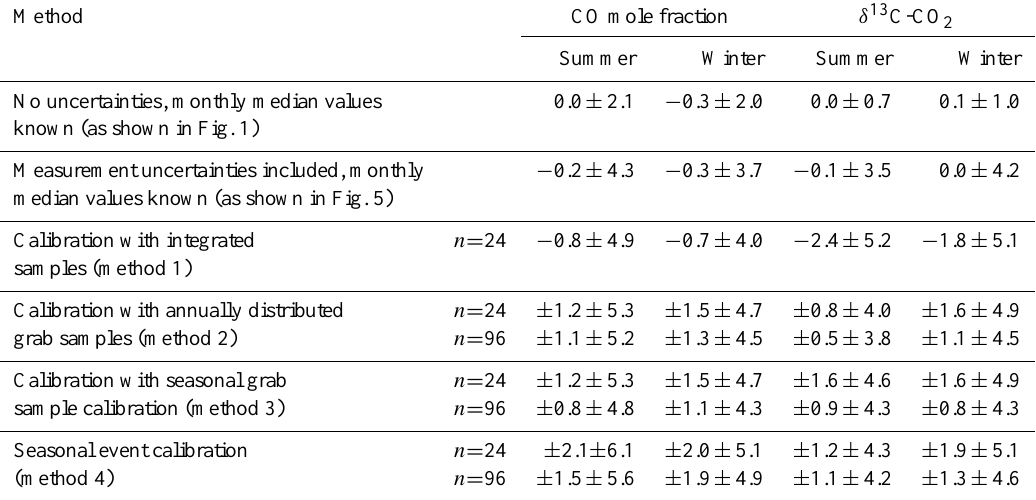
Table 4. Absolute mean difference of tracer-based estimate and modeled (assumed as correct) fuel CO 2 in µmolmol − 1 for the tracers CO and δ 13 C(CO 2 ) for different sampling strategies and respective standard deviation (both determined from a Gaussian fit to the difference histogram) for an urban setting (here: Heidelberg). Depending on the random selection of grab samples, the bias of the calibration with annually distributed grab samples is sometimes positive and sometimes negative. Therefore, the mean absolute difference between the modeled and calibrated value was determined in a Monte Carlo simulation and is shown with a “ ± ” sign in front of the mean value to show that the bias does not have a unique sign. The standard deviation denotes the 1 σ uncertainty of the difference, which is always bidirectional. Note that we only show the results for CO and δ 13 C(CO 2 ) , since the results when using a combination of these tracers are very similar to those of the δ 13 C(CO 2 ) method. Measurement uncertainties are included in all calibration